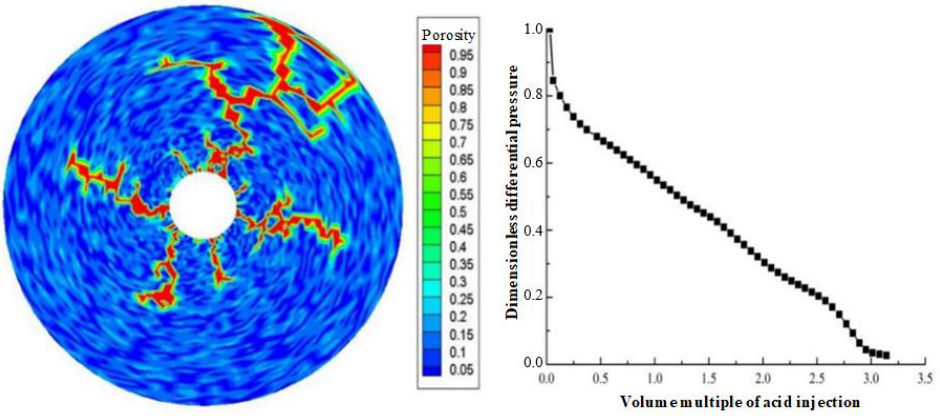
Figure 4. Change of dissolution form and differential pressure with gelling acid injection (gelling acid injection speed 0.065 cm/min).